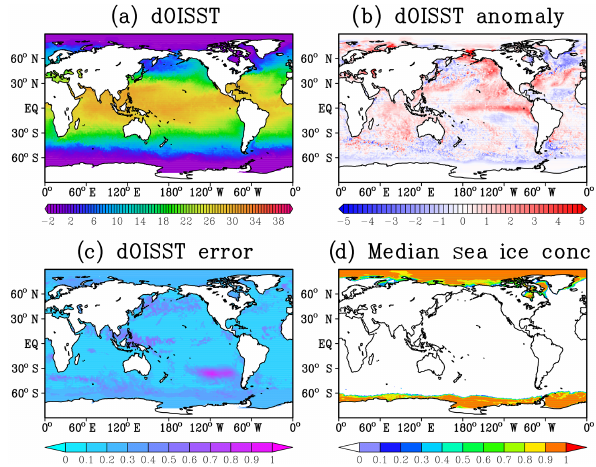
Figure 1. Examples of the four variables in a singles file: (a) dOISST.v2, (b) dOISST anomaly, (c) error, and (d) median sea- ice concentrations. Data are shown for 20 June